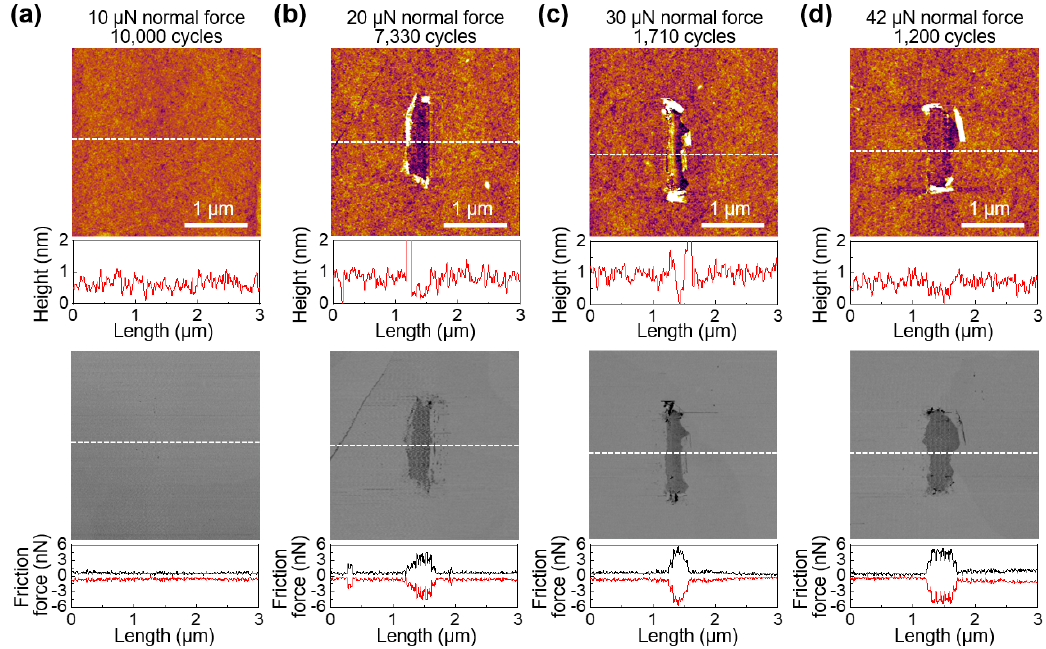
Figure 3. AFM topographies with cross-sectional profiles and FFM images with friction loops of 1L h-BN after ( a ) 10,000 cycles under a 10 µ N normal force, ( b ) 7330 cycles under a 20 µ N normal force, ( c ) 1710 cycles under a 30 µ N normal force, and ( d ) 1200 cycles under a 42 µ N normal force.